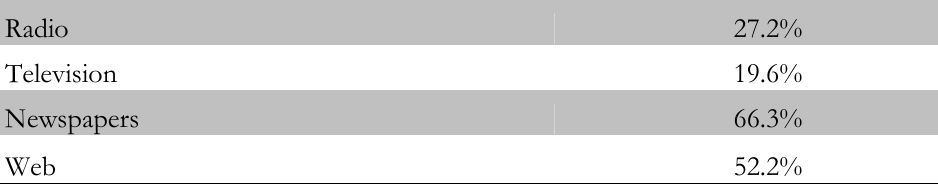
Table 8. Mobilized through the news